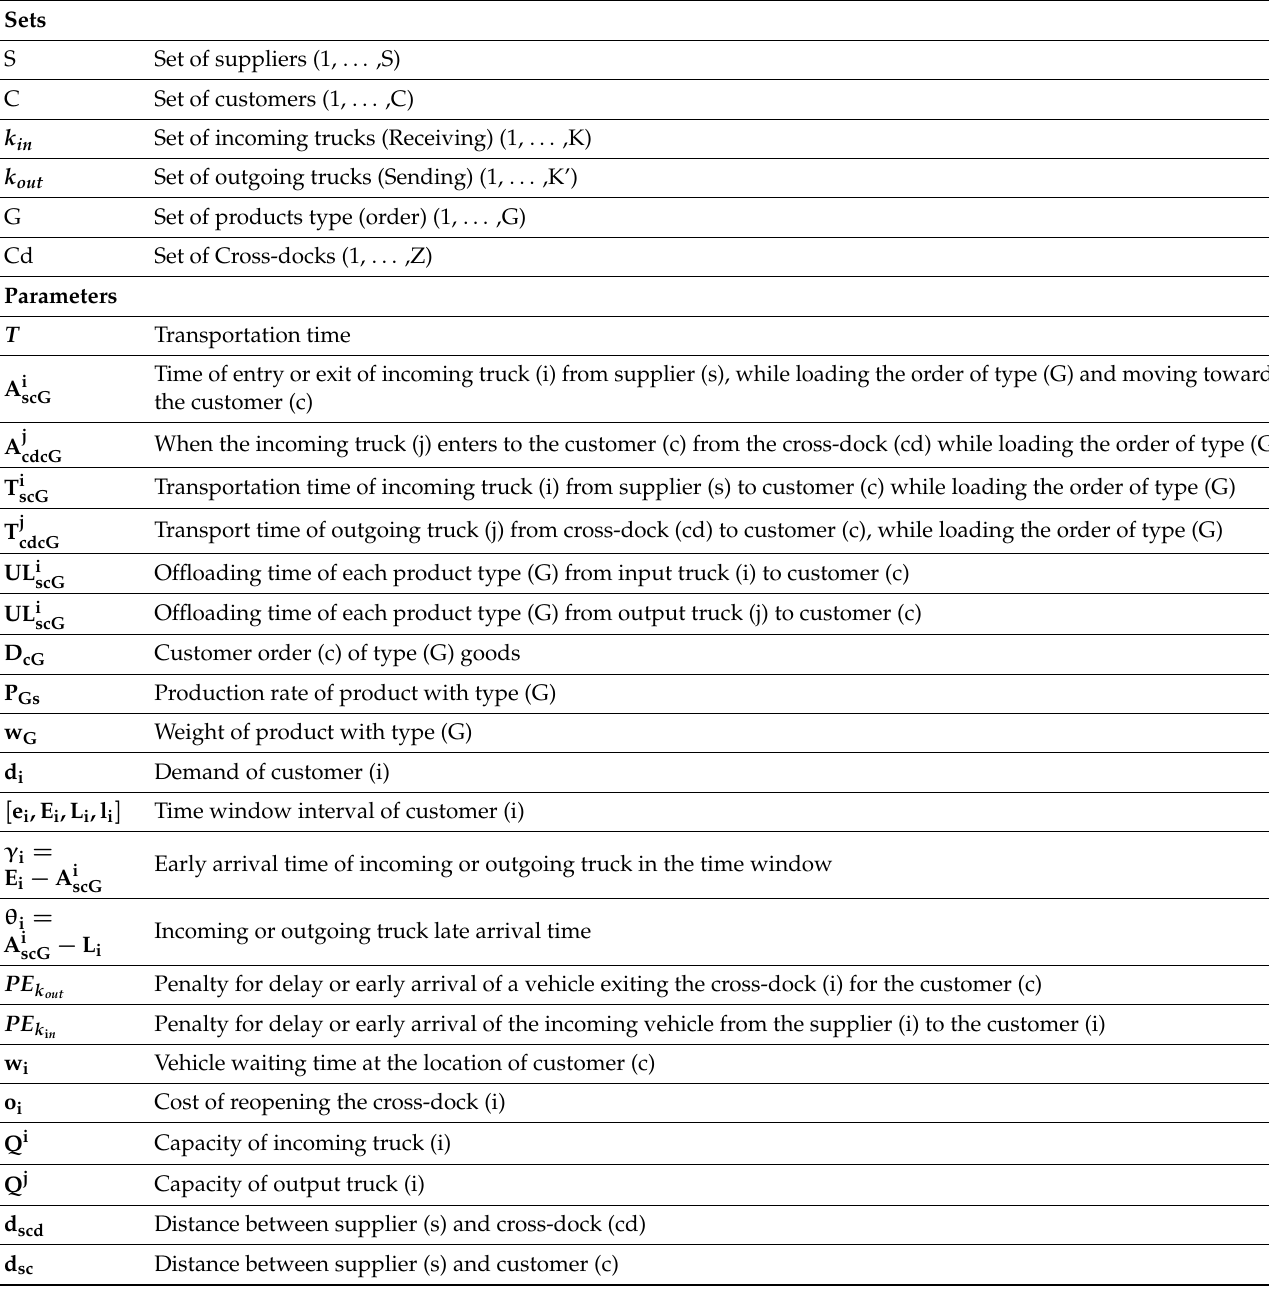
Table 2. Sets, parameters, and decision variables of the